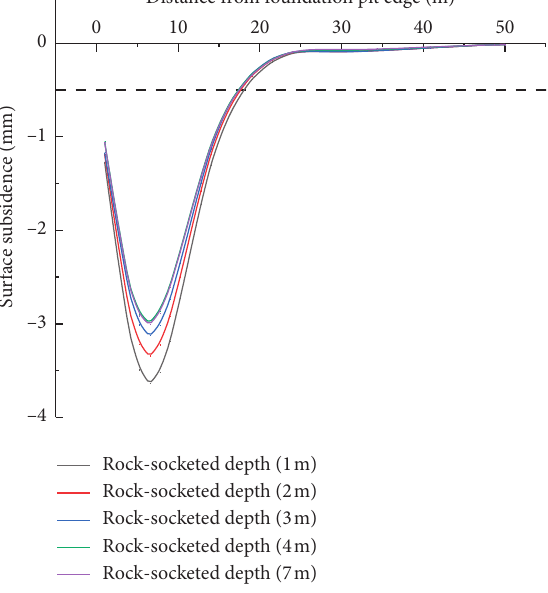
Figure 16: Surface subsidence outside the